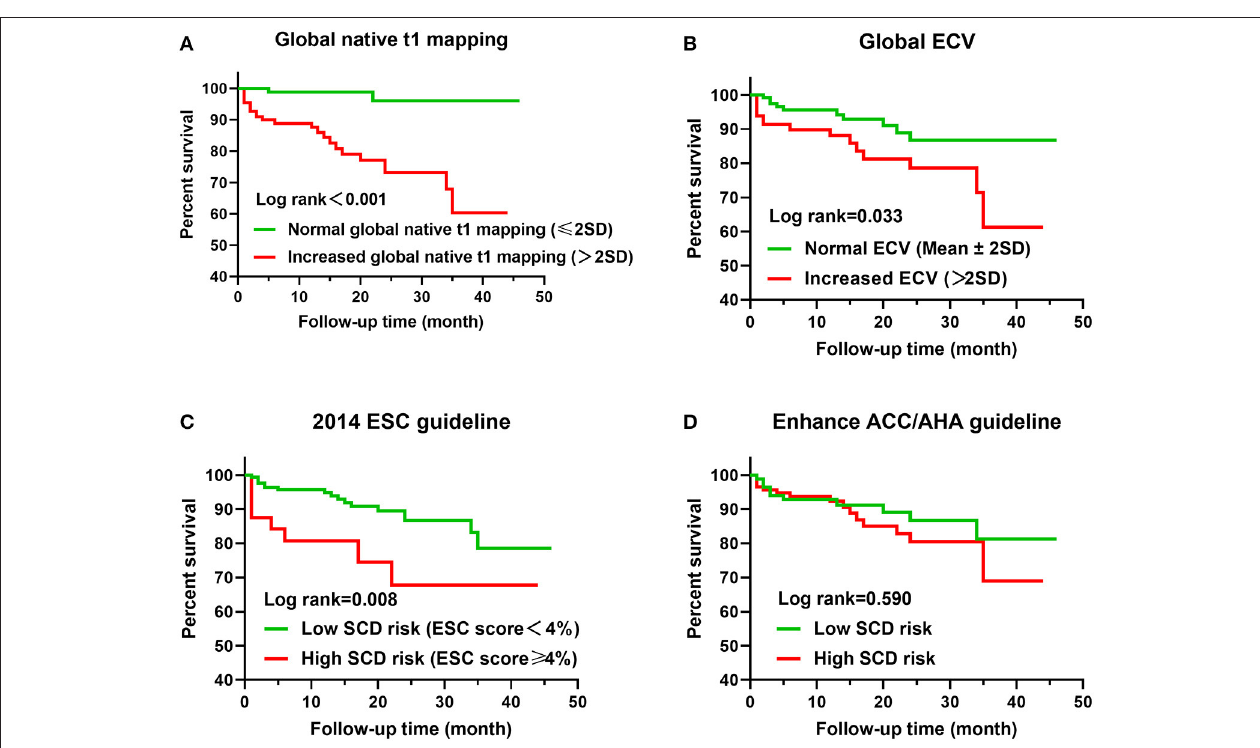
FIGURE 2 | Kaplan–Meier curves for T1 mapping values, risk stratification of guidelines, and MACE. (A) Global native T1 mapping > 2SD (60ms) vs. ≤ 2SD. (B) Global ECV > 2SD (4%) vs. ≤ 2SD. (C) ESC score < 4 vs. ≥ 4%. (D) Low SCD risk assessed by enhanced ACC/AHA guidelines vs. high SCD risk.